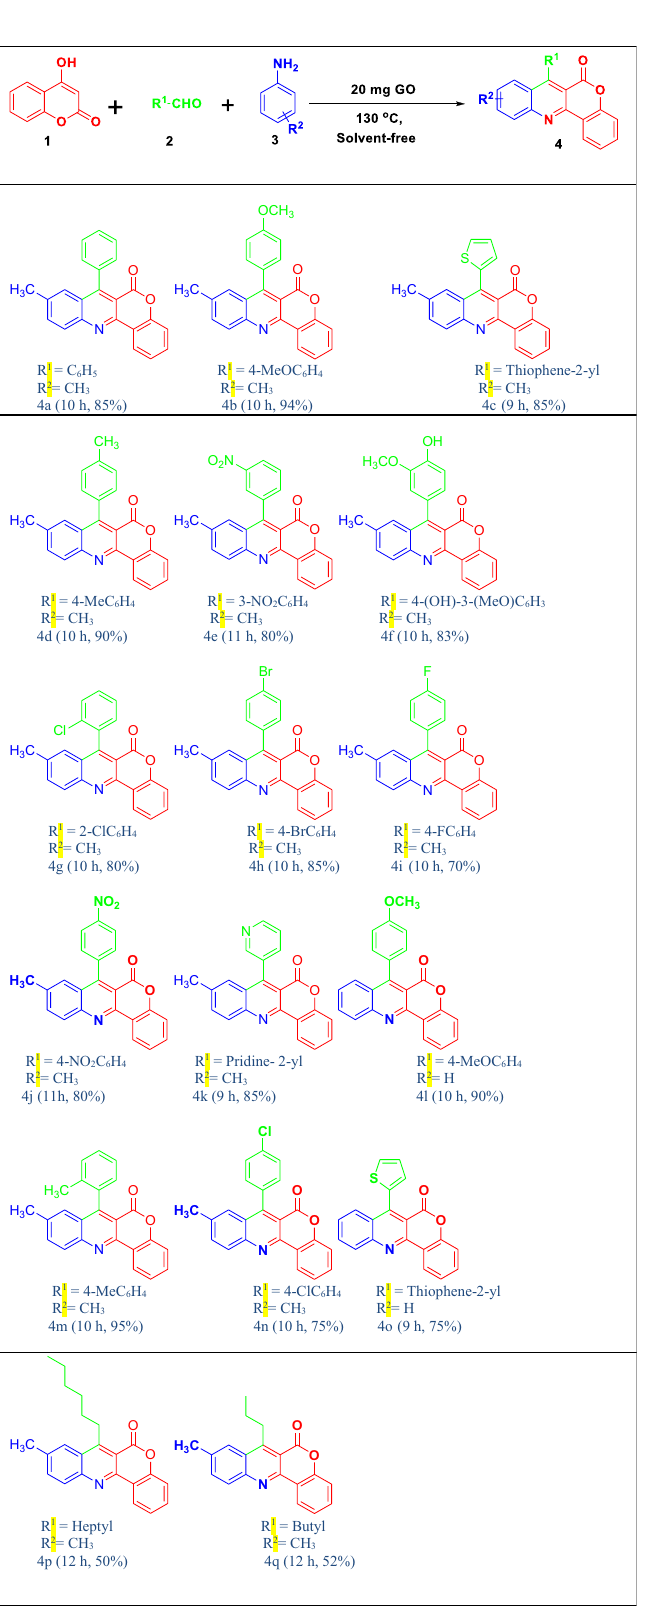
Table 2. Substrate scope of anilines and aldehydes for the synthesis of chromeno-[4,3- b ]-quinolin-6-ones in the protocol a